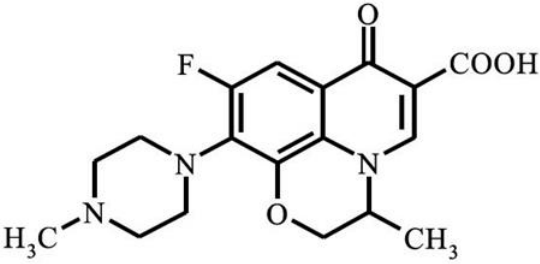
Figure 1. Chemical structure of ofloxacin (OFL).